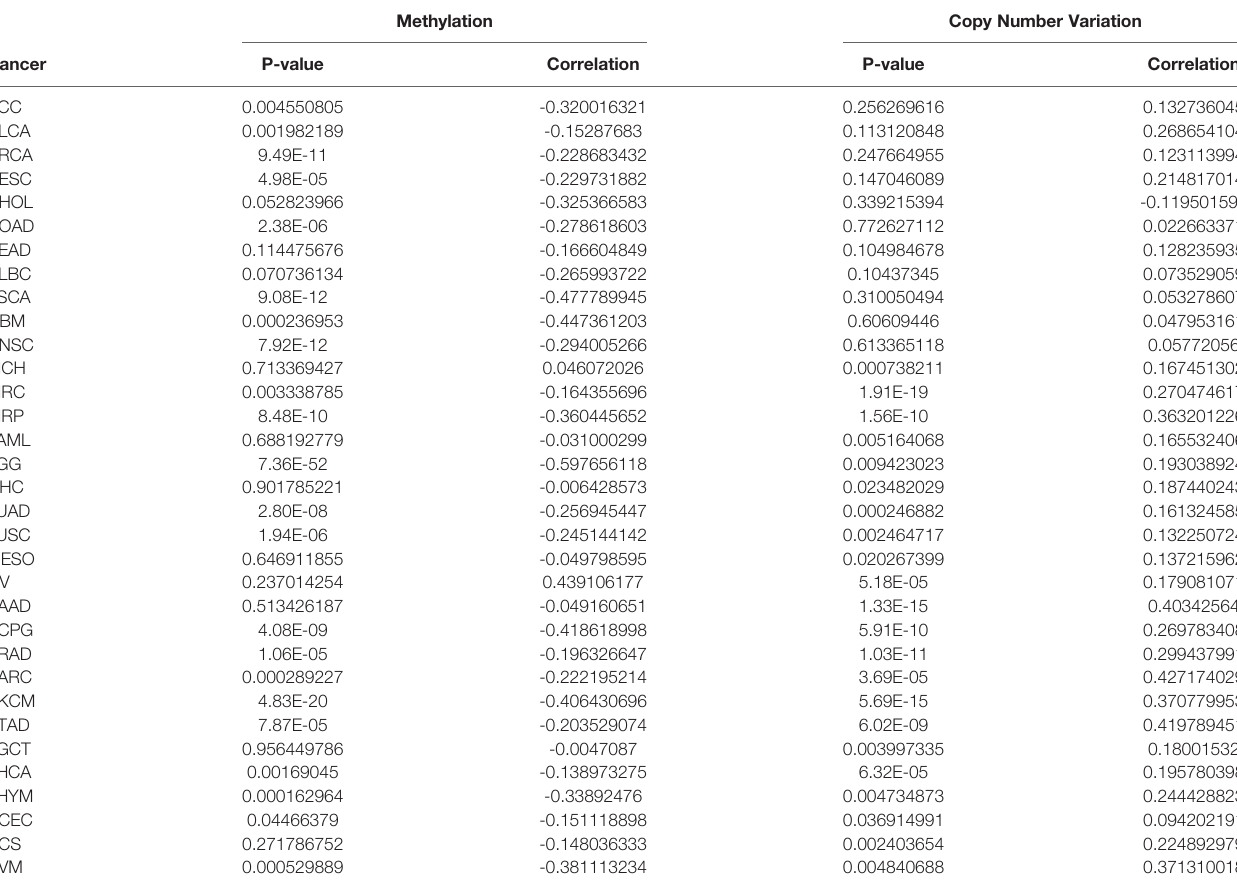
TABLE 1 | Correlation of NAAA expression with methylation and copy number variation